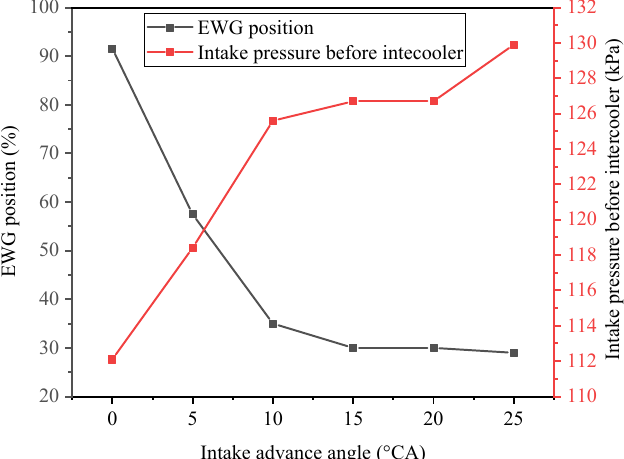
Figure 4. EWG (Electrical waste gate) position and intake pressure before intercooler versus intake advance angle (point of operation: n = 3000 rpm, BMEP = 10 bar, exhaust retardation angle = 25 °CA, CA50 = 8 °CA).